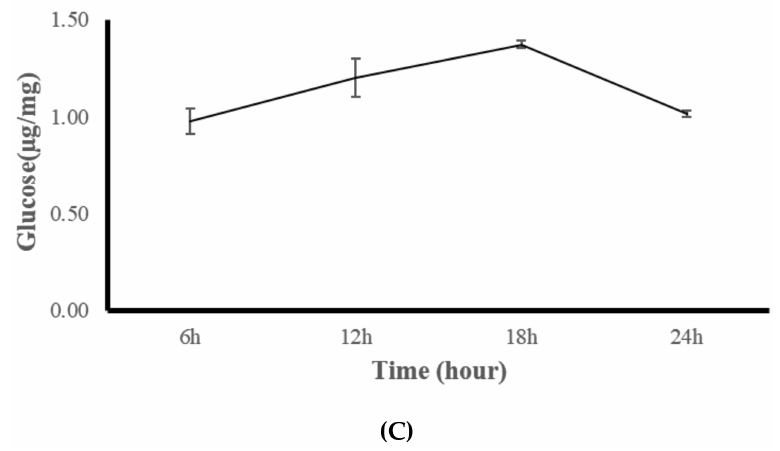
Figure 3. Changes in body composition of rich-animal-protein-fed (R-fed) G. columna over a 24-h period: ( A ) protein, ( B ) lipid, and ( C ) glucose content. Values are expressed as means ± SDs ( n = 30 colonies). Table 7. Changes in digestive enzymes of R-fed G. columna over a 24-h